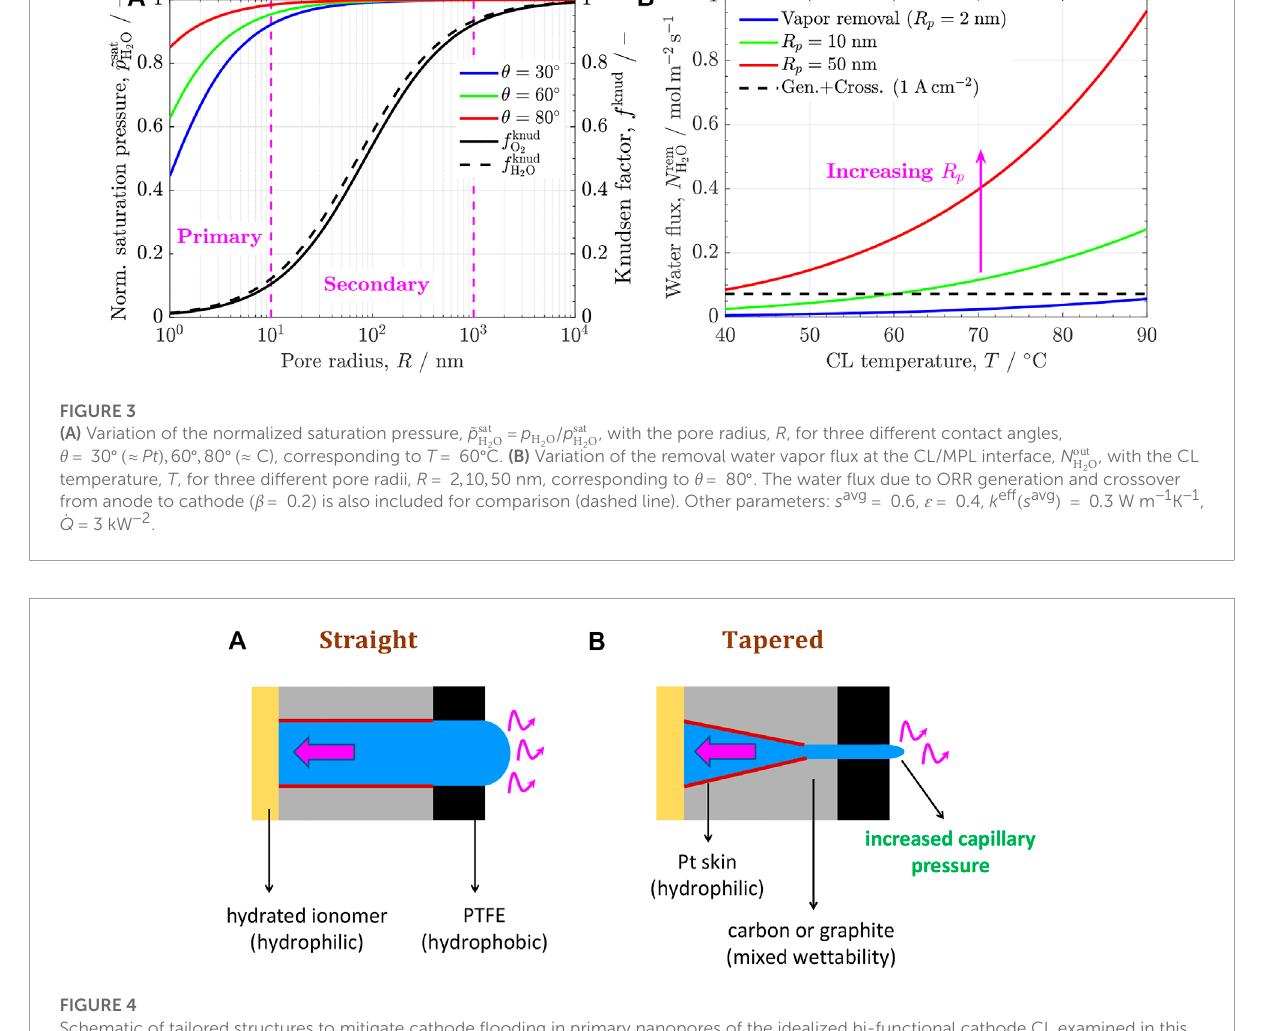
, with the CL 2 O